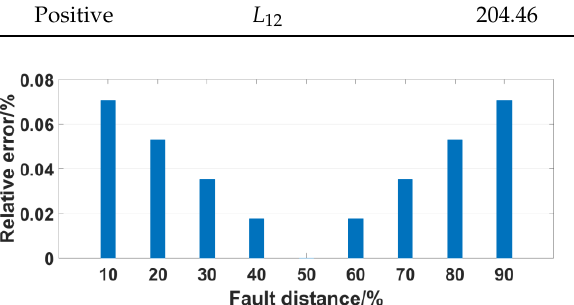
Figure 14. Relative errors of fault distance calculation under different fault distances.